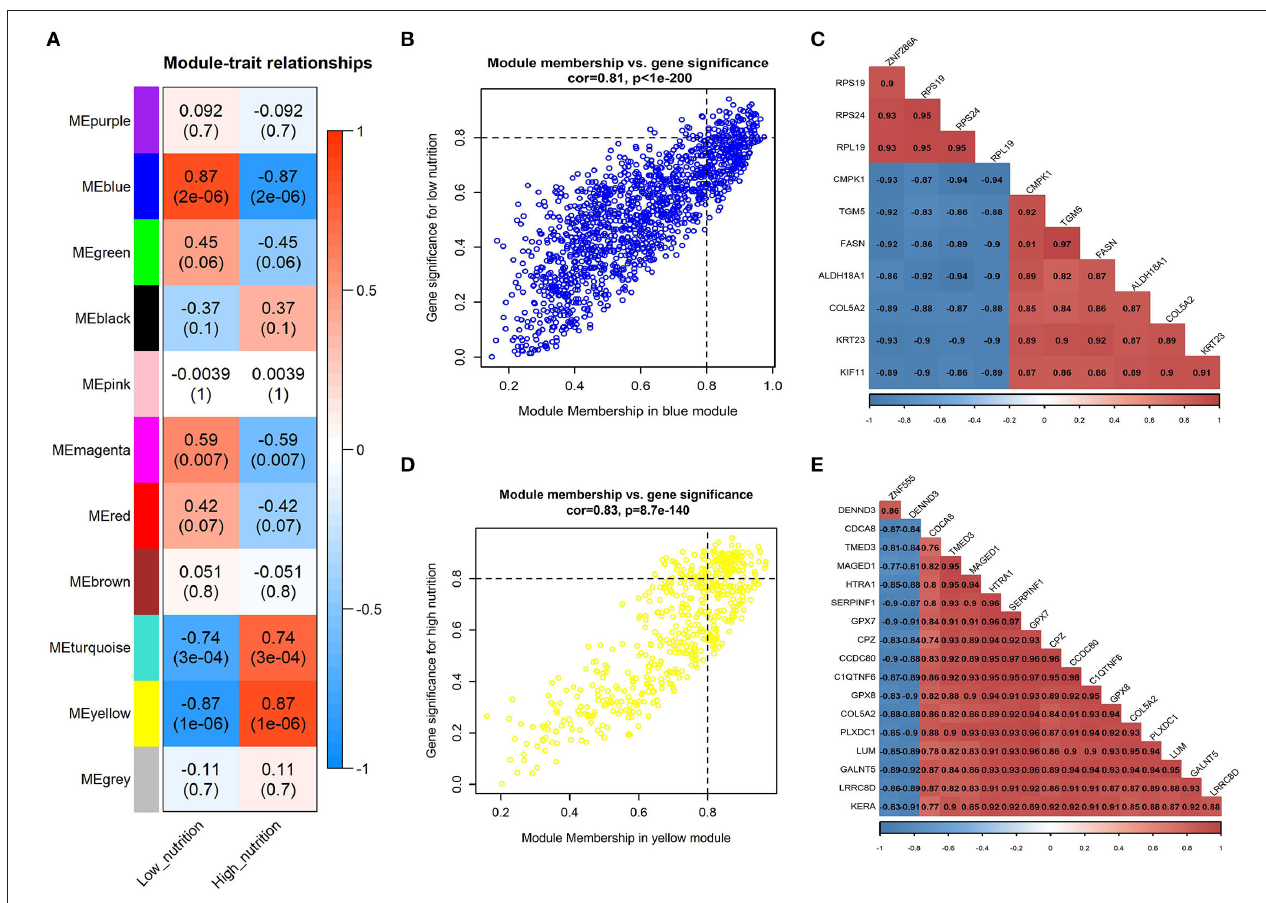
FIGURE 1 | Module-trait correlations analysis in subcutaneous adipose tissue (PRJNA382633). (A) Correlation heatmap between modules and nutrition levels. The correlation coefficient and P -value are labeled in the rectangle. (B) The MM and GS for low nutrition in the blue module. The dots represent genes in the blue module, the horizontal axis is the MM value, and the vertical axis is the GS value for low nutrition. (C) The correlation relationship of the top 10 genes with high MM and GS in the blue module. The correlation coefficients are labeled in the rectangle. (D) The MM and GS for high nutrition in the yellow module. The dots represent genes in the yellow module, the horizontal axis is the MM value, and the vertical axis is the GS value for high nutrition. (E) The correlation relationship of the top 17 genes with high MM and GS in the yellow module. The correlation coefficients are labeled in the